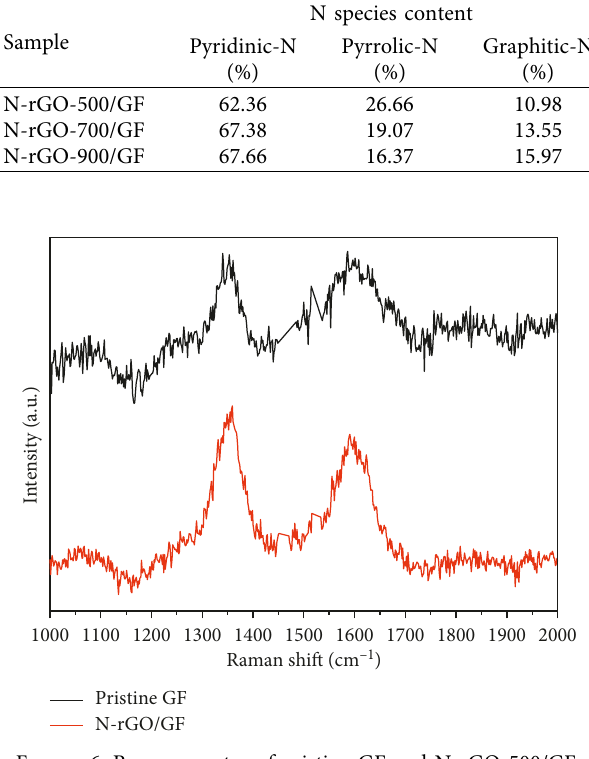
Figure 6: Raman spectra of pristine GF and N-rGO-500/GF.